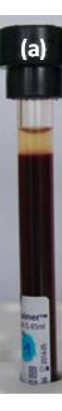
Figure 7. Sedimentation test results of sample from Donor #1: ( a ) vial contains original blood sample and ( b ) vial the sample with P(PEGMA-AA)@MNP added at 0.24 mg/mL concentration.